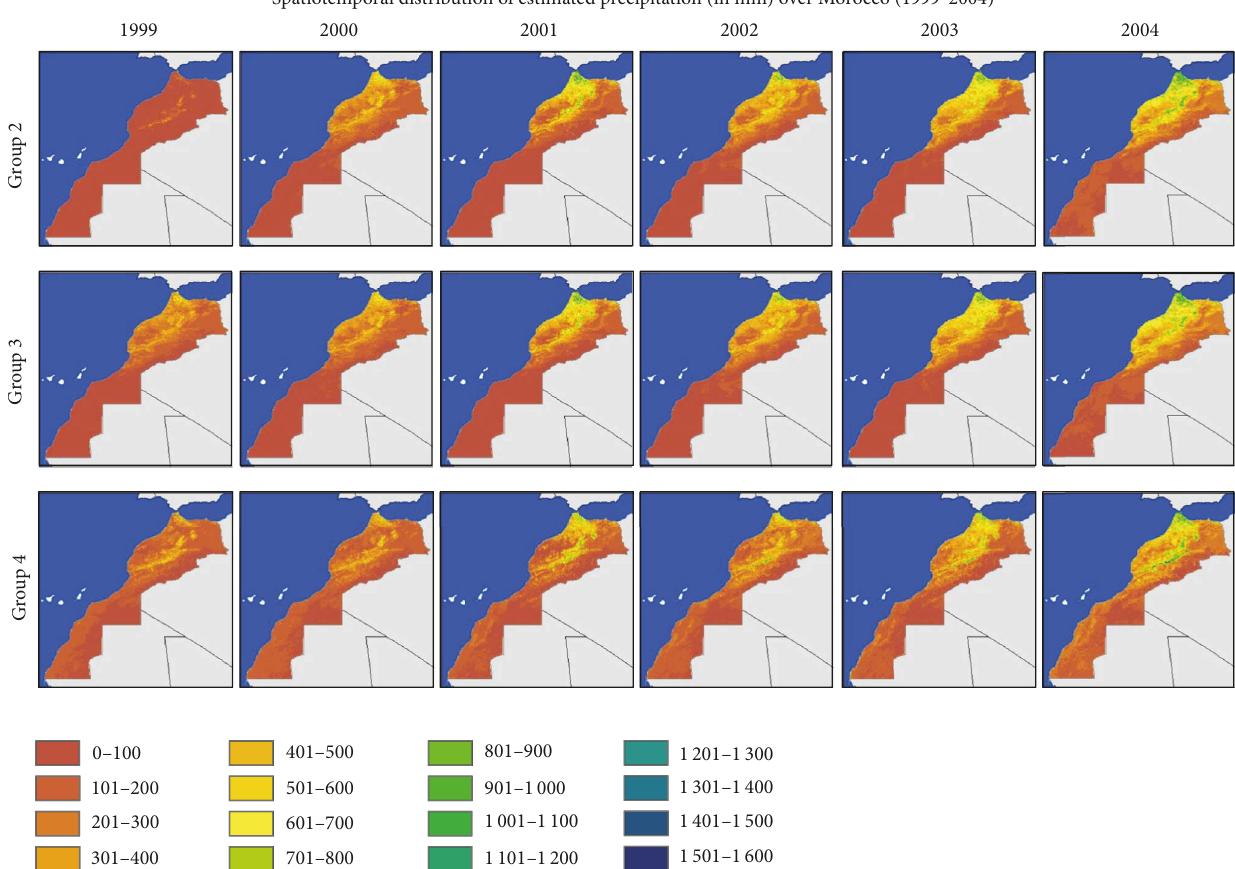
Figure 5: Spatial distribution of precipitation over Morocco according to TRMM 3B43 product, estimated precipitation using models of Group 2 (NDVI, NDWI, altitude, and distance), Group 3 (NDVI, altitude, and distance), and Group 4 (NDWI, altitude, and distance).